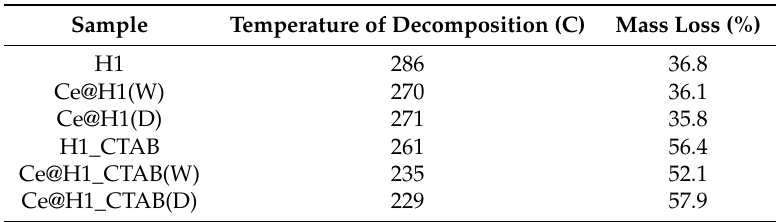
Table 3. Temperature of structure decomposition and mass loss due to combustion of BTC linker.